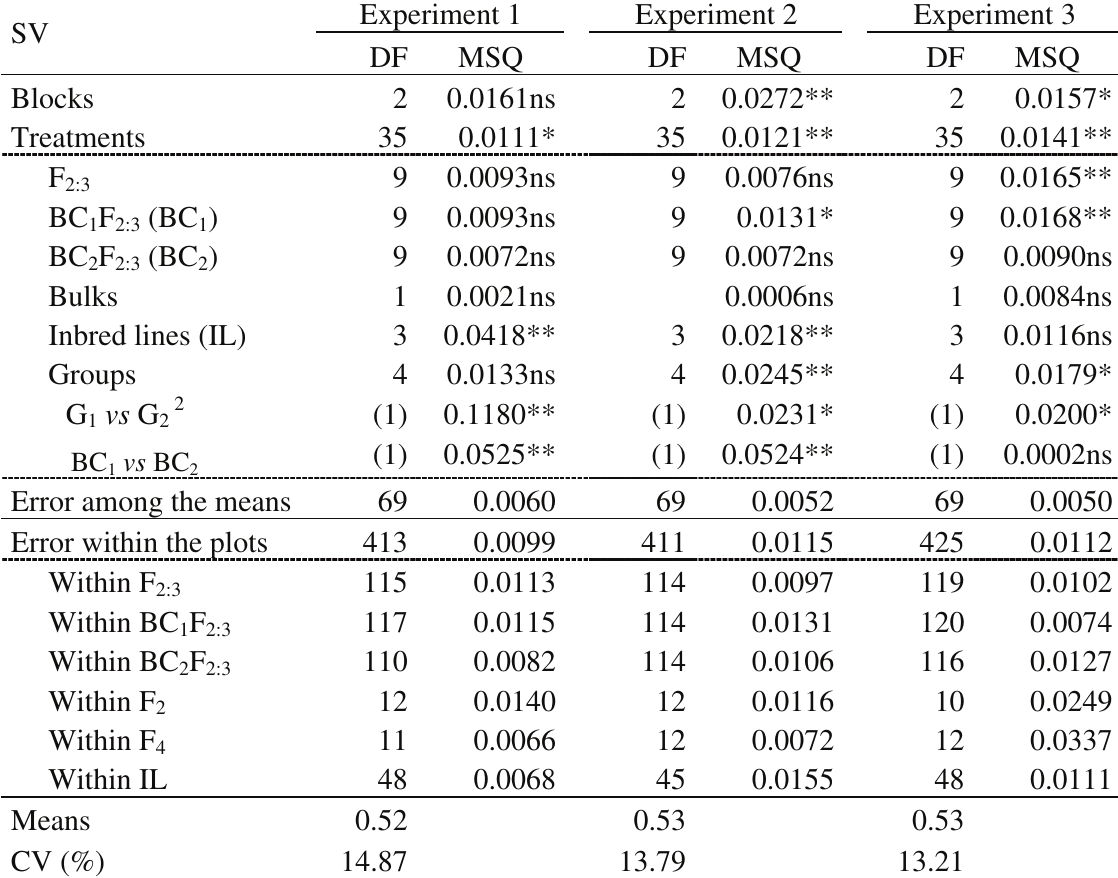
Table S5 – Summary of analysis of variance, with those mean squares associated to variation among the means and within the plots from the respective sources of variation for the trait percentage index of pod damage in soybeans